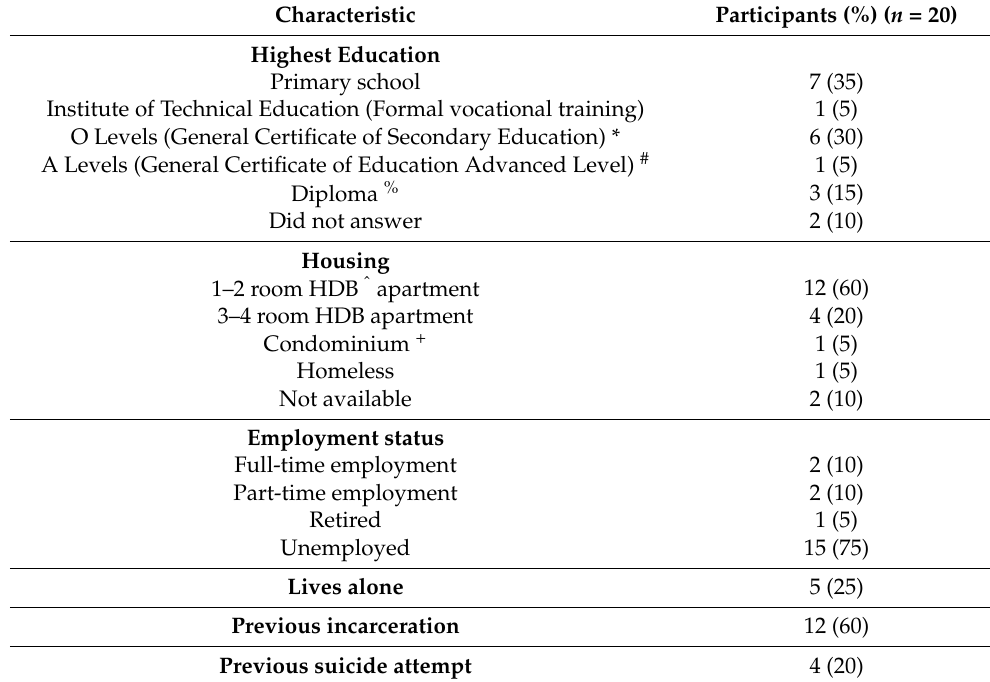
Table 2. Socio-economic